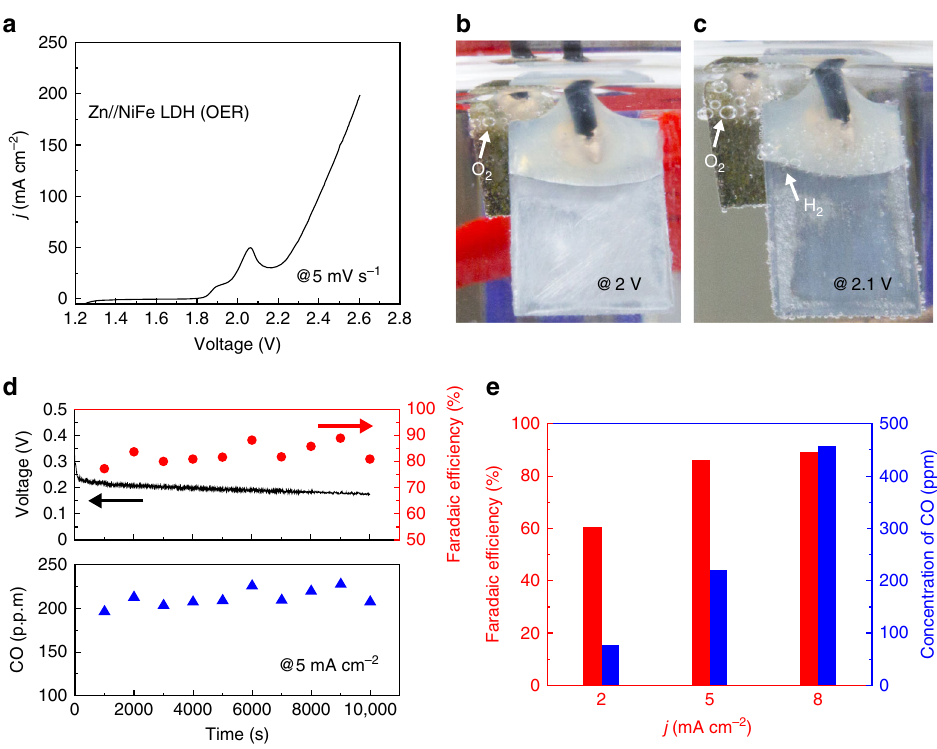
Fig. 3 Oxygen evolution and CO 2 reduction. a The j – V curve of electrochemical oxygen evolving in the two-electrode Zn//NiFe hydroxide system from linear sweep voltammetry. The scan rate was 5 mV ∙ s − 1 . b , c Photographs of hydrogen evolution on a Zn plate at a voltage of 2.0 and 2.1 V, respectively. d The chronovoltammetry pro fi le, FE CO and concentration of CO production in the two-electrode Zn//nano-Au system at a current density of 5 mA ∙ cm − 2 . e FE CO (red bars) and concentration of CO production (blue bars) at different current densities of 2, 5 and 8 mA ∙ cm −